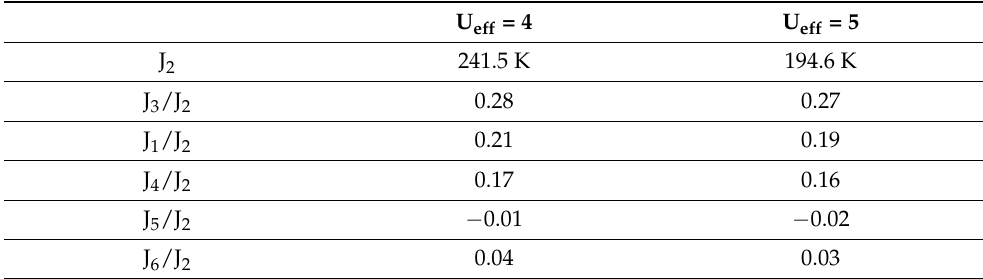
Figure 22. ( a ) Arrangement of the spin exchange paths J 1 –J 6 in Azurite. ( b ) Arrangement of the four strongest spin exchanges J 1 –J 4 in Azurite. ( c ) 2D spin lattice describing Azurite. Table 1. Values of the spin exchanges J 1 –J 6 determined by DFT+U calculations with U eff = 4 and 5